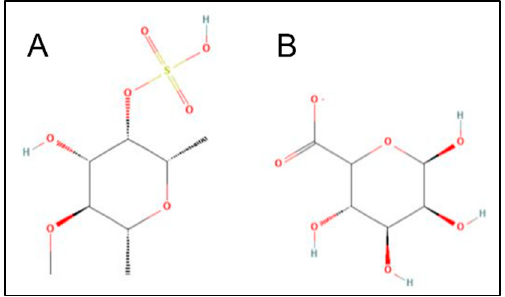
Figure 3. 2D chemical structure of fucoidan ( A ) and alginate ( B